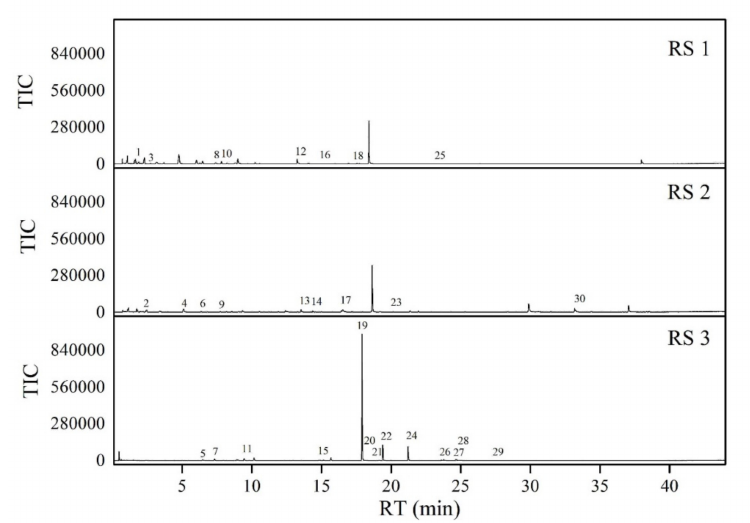
Figure 5. Total ion chromatograms of Shine Muscat grape berry extracts at di ff erent ripening stages: RS1, ripening stage 1; RS2, ripening stage 2; and RS3, ripening stage 3. The increasing numbers behind the abbreviation RS indicate the degree of ripening. (1) 3-Methyl butanal, (2) Pentanal, (3)